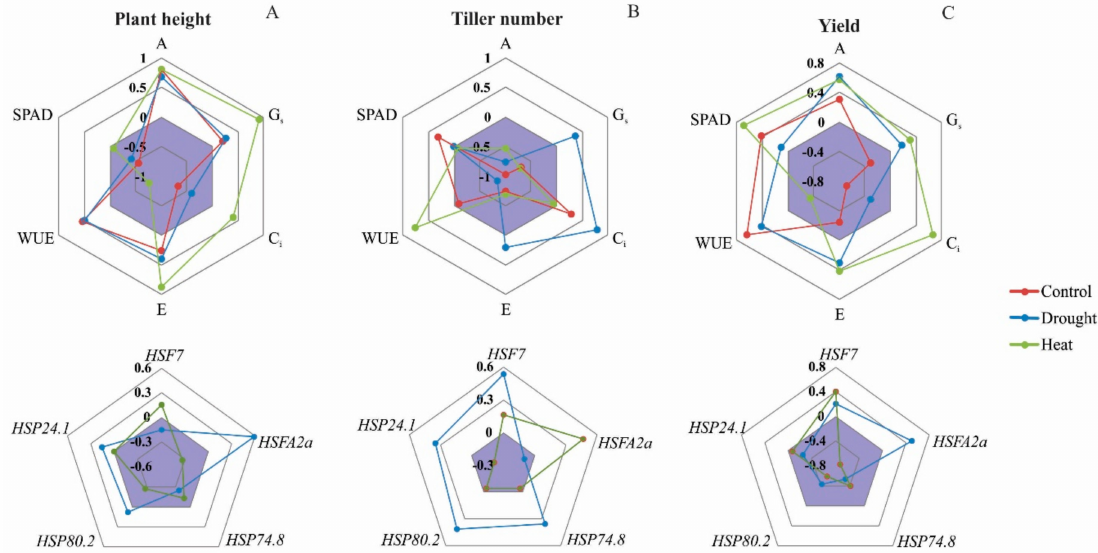
Figure 6. Graphic representation of Pearson correlations between photosynthesis-related variables and HSFs and HSPs gene expression in rice cultivars and weedy rice genotypes under normal growing conditions, drought stress, and heat stress. Plant height correlations ( A ); Tiller number correlations ( B ); Yield correlations ( C ). Photosynthesis rate (A); Stomatal conductance (G s ); Intercellular CO 2 concentration (C i ); Transpiration rate (E); Water use efficiency (WUE); Chlorophyll meter index (SPAD). The shaded area at the center represents a negative